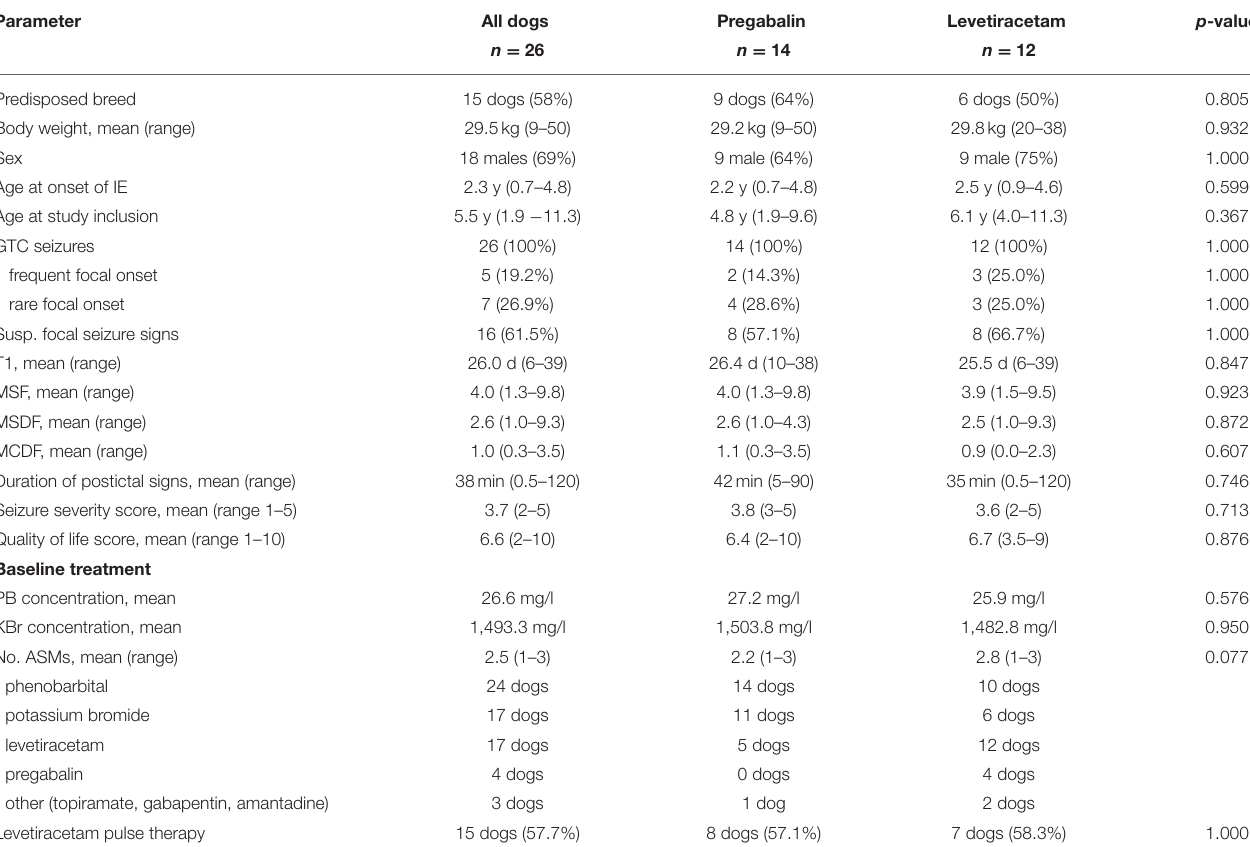
TABLE 2 | Baseline characteristics of enrolled dogs with drug-resistant idiopathic epilepsy.